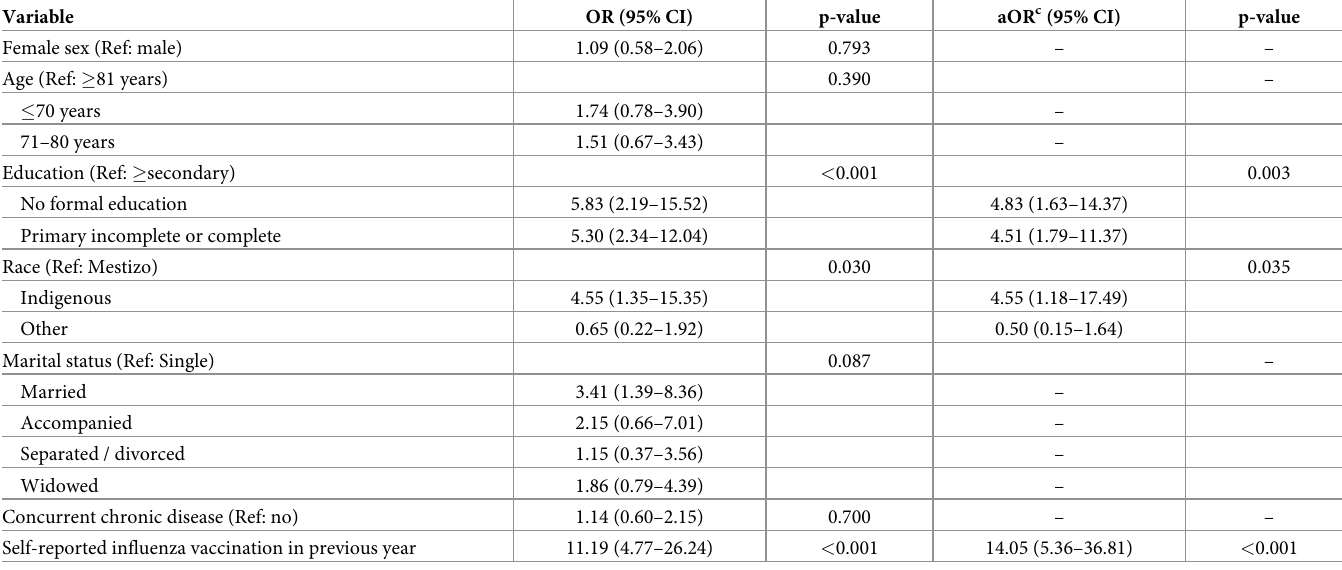
erence. The Hosmer-Lemeshow goodness-of-fit test demonstrated the model fit was adequate (p = 0.93). Tolerance values for all independent variables were > 0.99, so there was no evidence Table 3. Associations between demographics and influenza vaccination (verified a ), older adults in nursing homes and daycare centers b (n = 267) c , Honduras, August 29 to October 26,